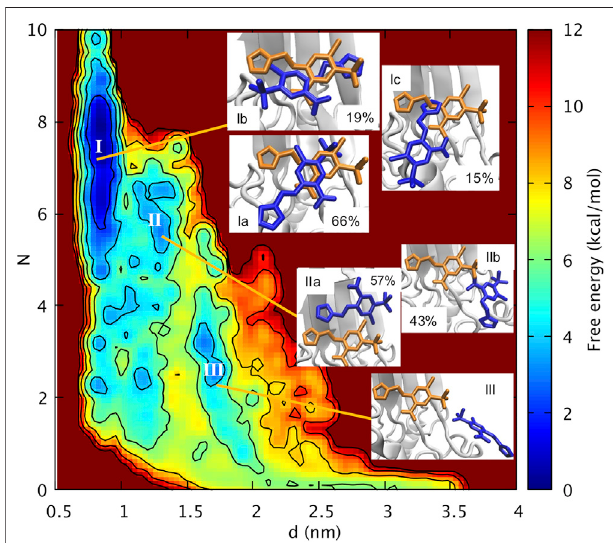
FIGURE 3 | Free energy of furosemide unbinding as a function of the distance between the centers of mass of the furosemide and of the Fe-S cluster ( d ) and the number of H-bonds/salt bridges ( N )